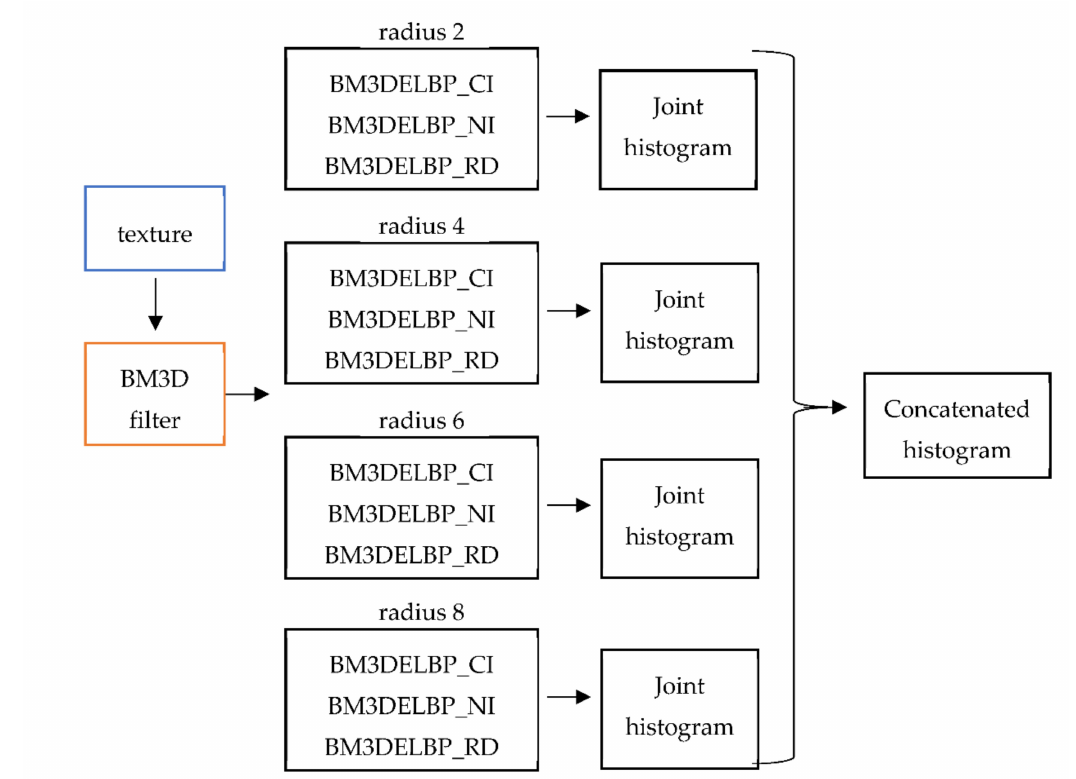
Figure 1. The functional block scheme of the BM3DELBP operator.